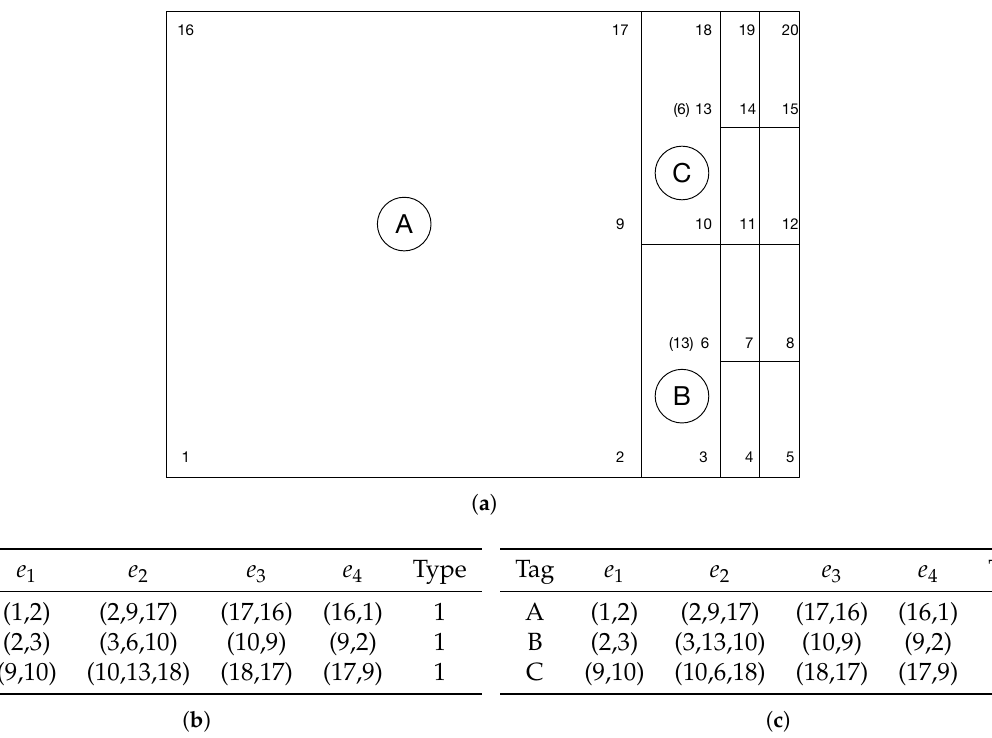
Figure 5. Boundary layer mesh example. Four levels of elements toward the right hand boundary. Normalised AEs are given as node lists, every split edge has the same parametrisation on the reference element. Types are labelled in the order of occurrence. ( a ) Boundary layer mesh. ( b ) Uniform: List of AEs and AREs (types). The node identifiers 6 and 13 have been swapped and hence all three labelled elements have different types. ( c ) Non-uniform: ( 6 ) ↔ ( 13 ) : List of AE and ARE (types). The nodes are given identifiers in the order of creation. Thus, in both instances